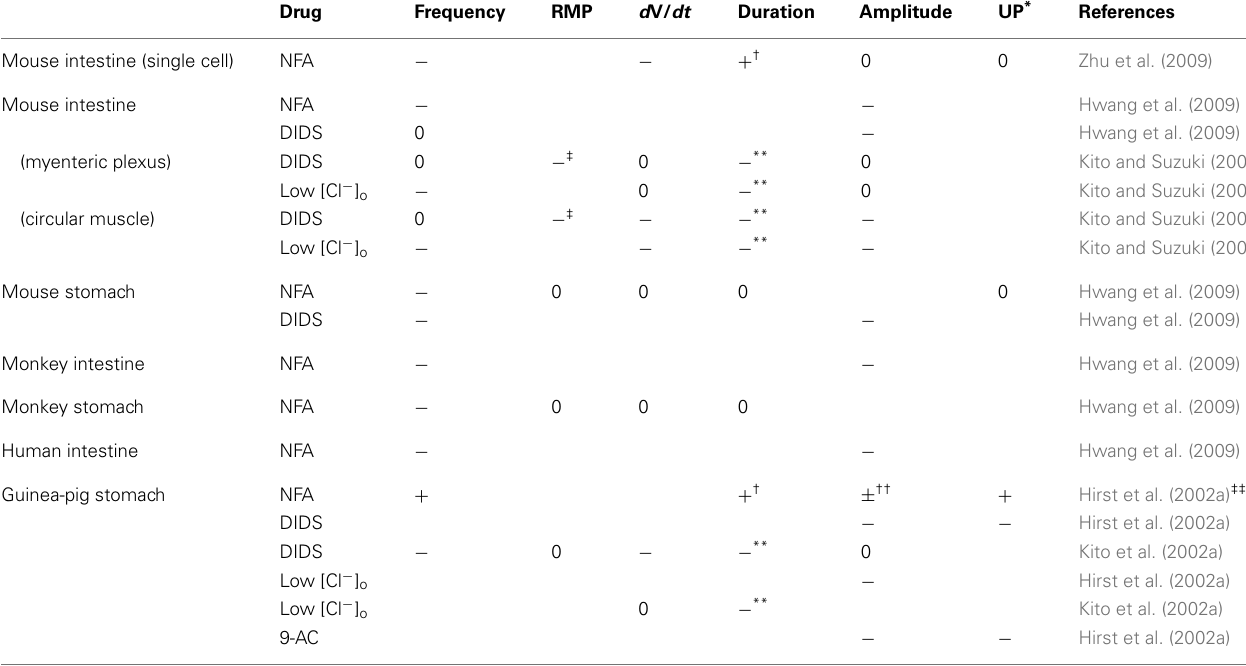
Table 1 | Effects of Cl − channel blockers on slow waves recorded from isolated ICC (first row only) and GI tissue